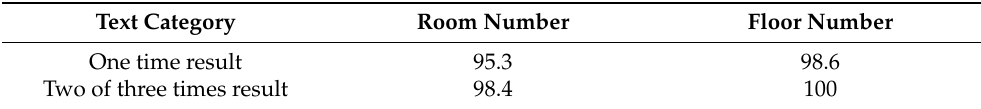
Table 1. Average recognition accuracy (%) in different